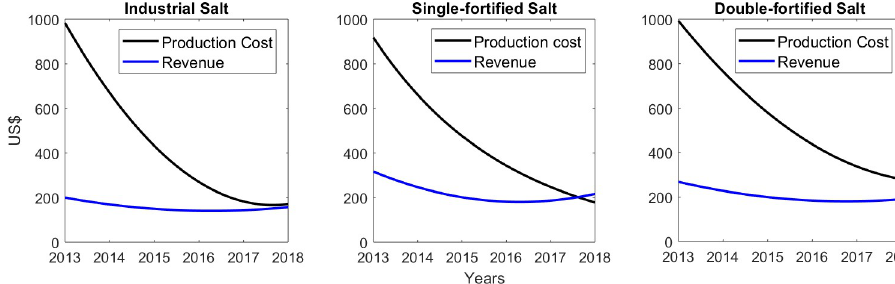
Fig 2. Revenue and production cost for industrial, single-fortified and double-fortified salt. Both revenue and production cost (in US$) for each salt are shown per